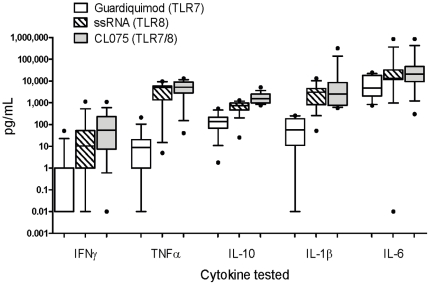
TLR7 and 8 agonist-induced cytokine induction in cord blood.100 µl of whole cord blood was cultured overnight with each of the
TLR agonists and supernatants recovered for measurement of IFNγ,
TNFα, IL-10, IL-1β and IL-6 as described in Materials and Methods (pg/mL),
n = 12–15. Unstimulated
values are subtracted from stimulated values and presented as box and
whisker plots, n = 12–15.